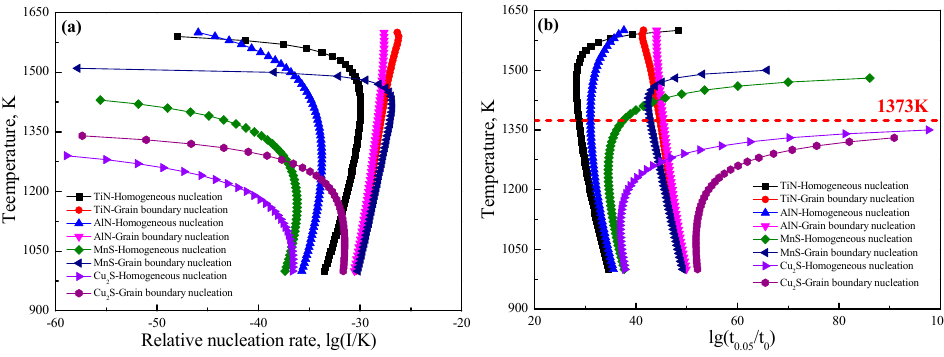
Figure 9. NrT ( a ) and PTT ( b ) curves of new phases precipitated in austenite.